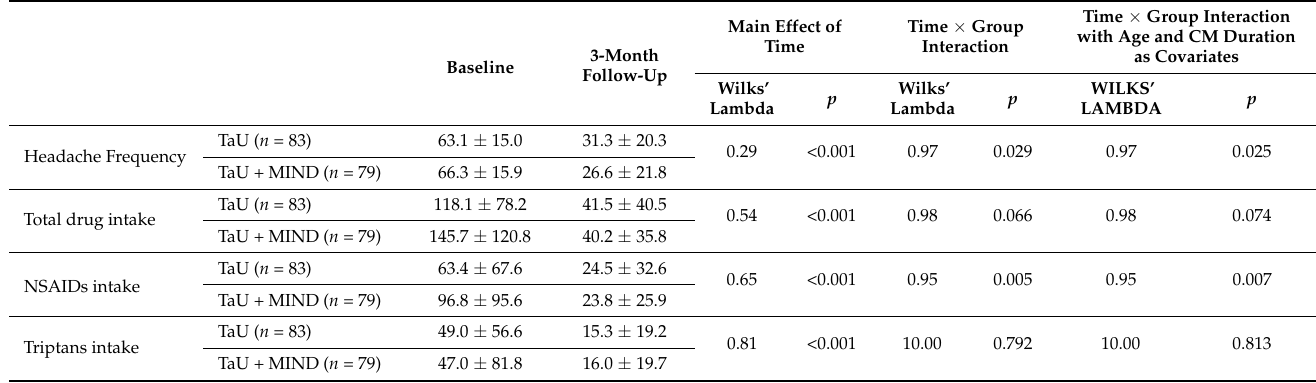
Table 2. Repeated measures ANOVA between baseline and three months. Time × Group Interaction Main Effect of Time × Group with Age and CM Duration Time Interaction 3-Month as Covariates Baseline Follow-Up Wilks’ p Wilks’ p WILKS’ p Lambda Lambda LAMBDA 63.1 ± 15.0 31.3 ± 20.3 0.29 <0.001